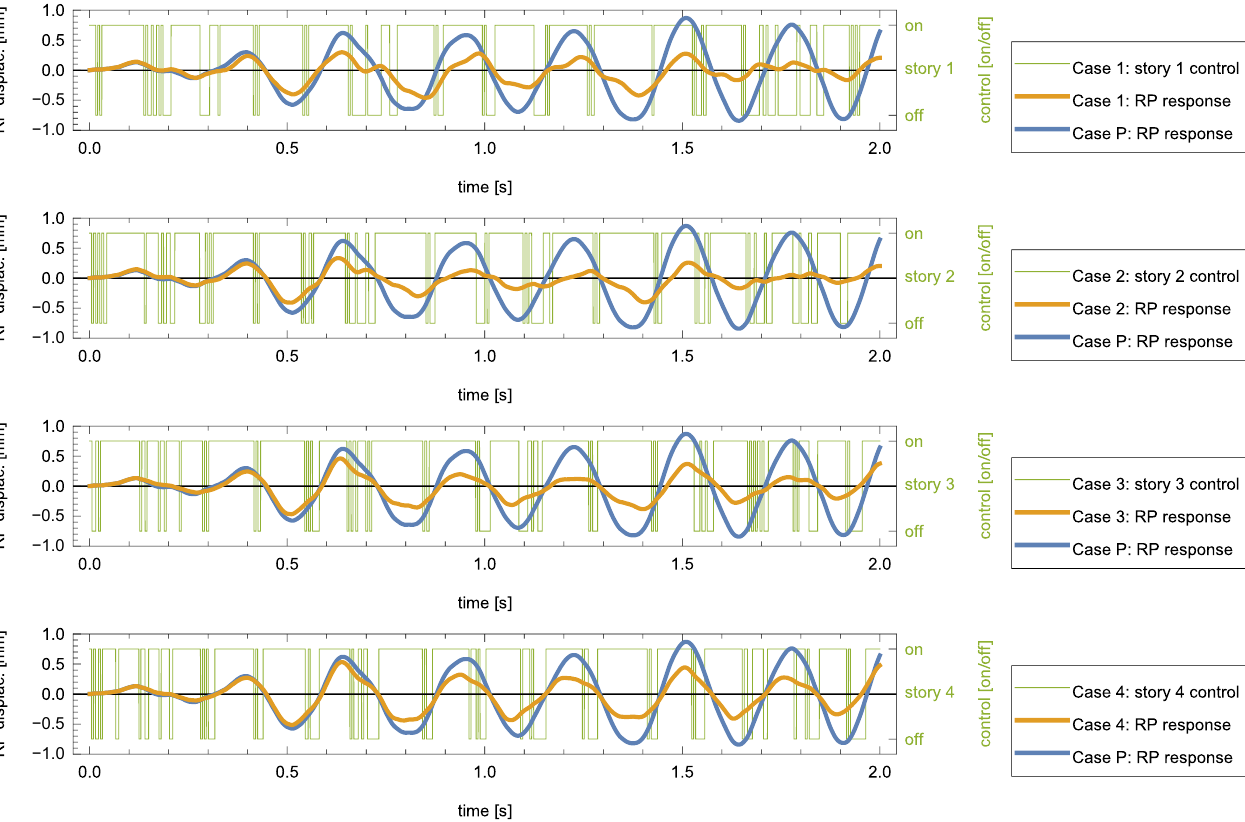
Figure 5. Control functions for the single controlled story structures together with the corresponding RP displacements (Cases 1–4) and the reference RP displacement in the passive structure (Case